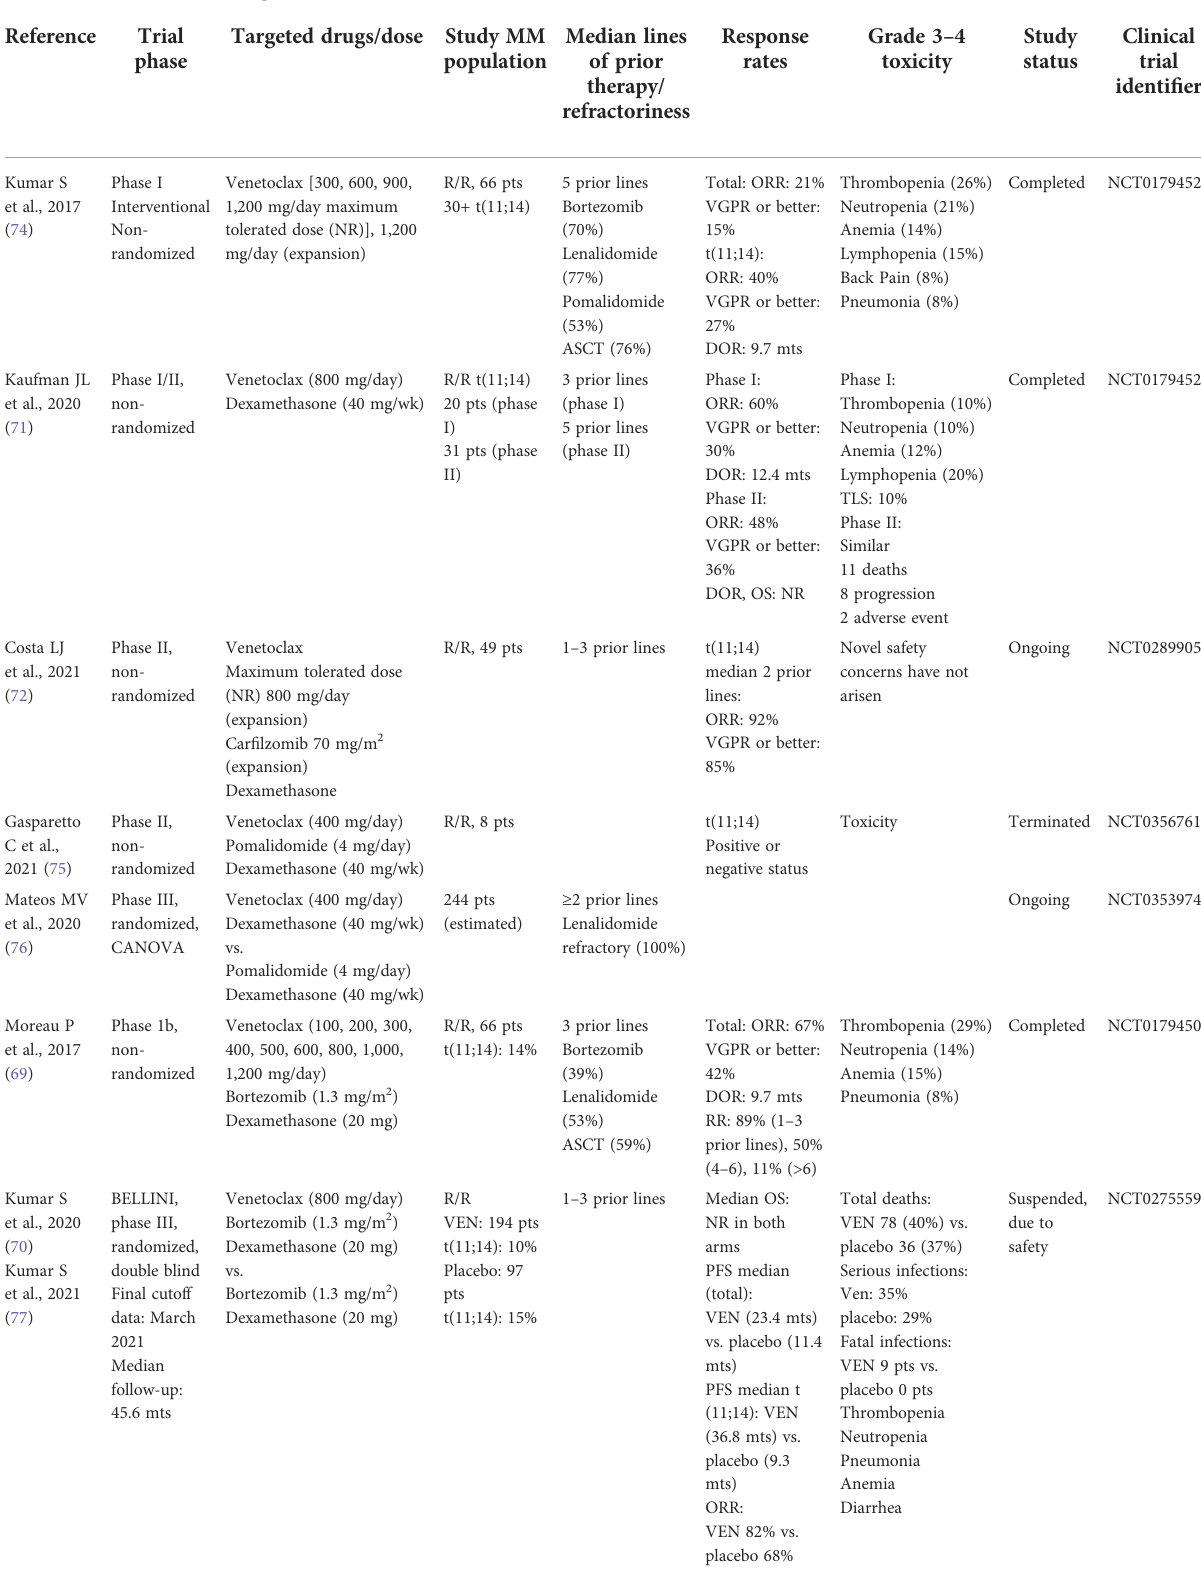
TABLE 1 Clinical trials involving